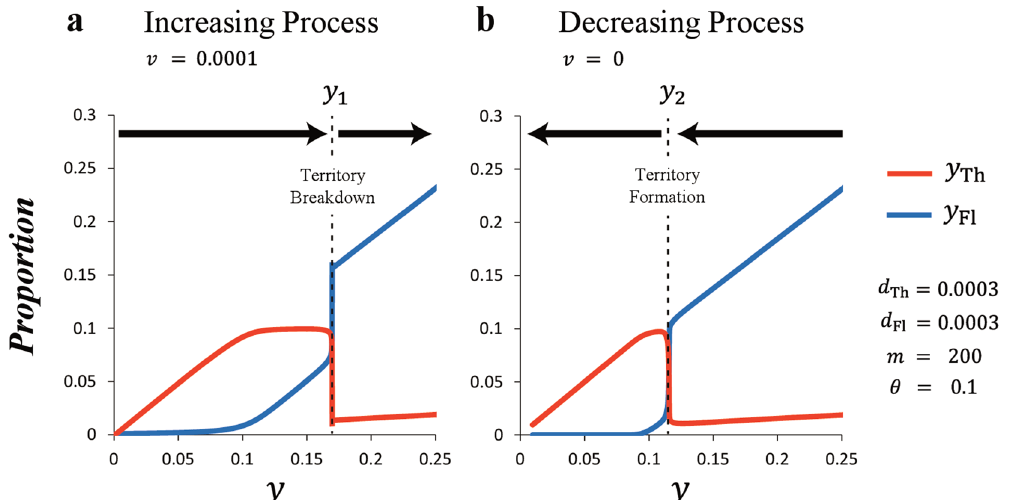
Figure 4. Territorial hysteresis has two significantly different transition proportions. We change the horizontal axis of Fig. 2 from time step t to the total proportion of ayu fish y ( = y Th + y Fl ). All model parameters are the same as the conditions used in Fig. 2. The red (blue) lines denote the proportion of territory holders (floaters). ( a ) In the increasing process, when y exceeds the critical proportion y 1 , all territories break down. ( b ) In the decreasing process, when N decreases and falls below the critical proportion y 2 , territories are directly reformed from the school. These two transition proportions y 1 and y 2 greatly